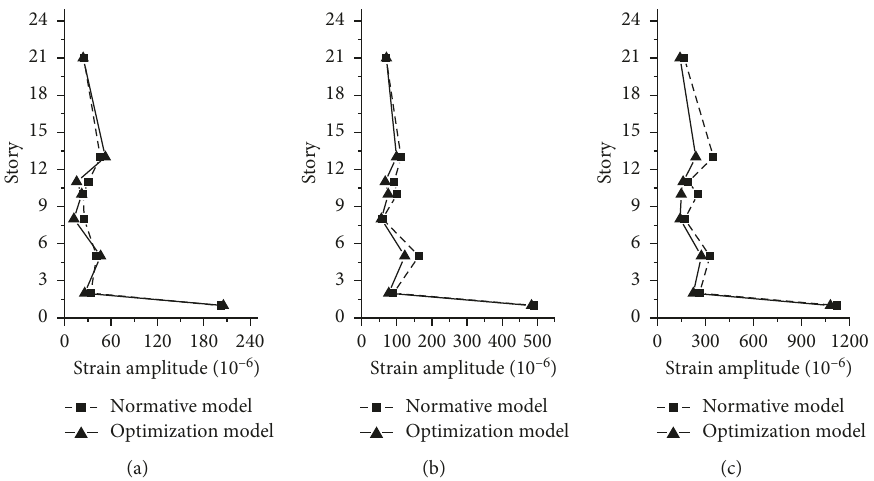
Figure 9: Maximum strain value of wall limb at different story. (a) Frequent intensity 7, (b) basic intensity 7, and (c) rare intensity